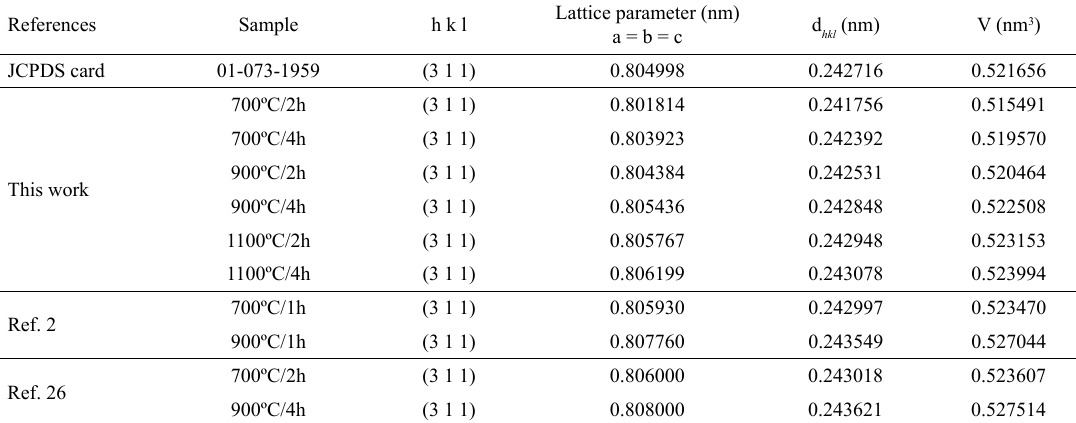
Table 1. Lattice parameter from the obtained XRD data.